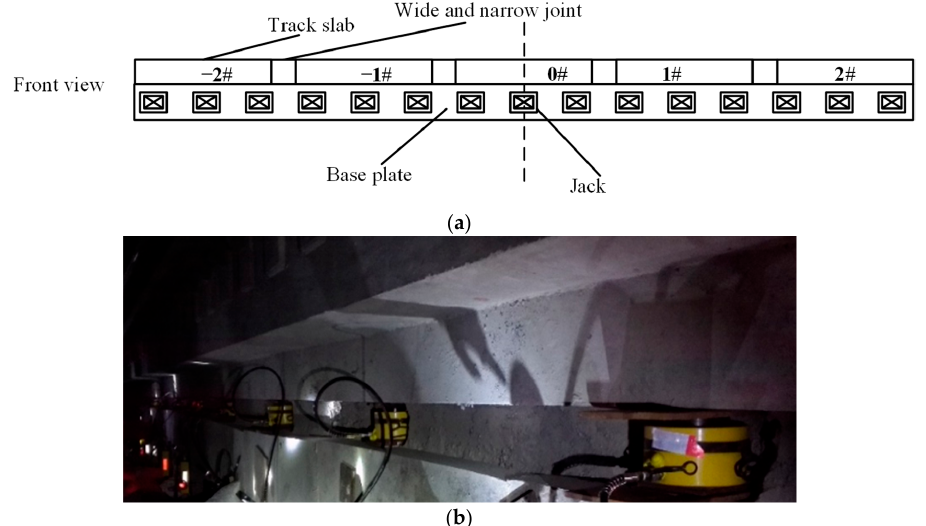
Figure 7. Multi-point jacking, ( a ) the schematic diagram, ( b ) picture on site.